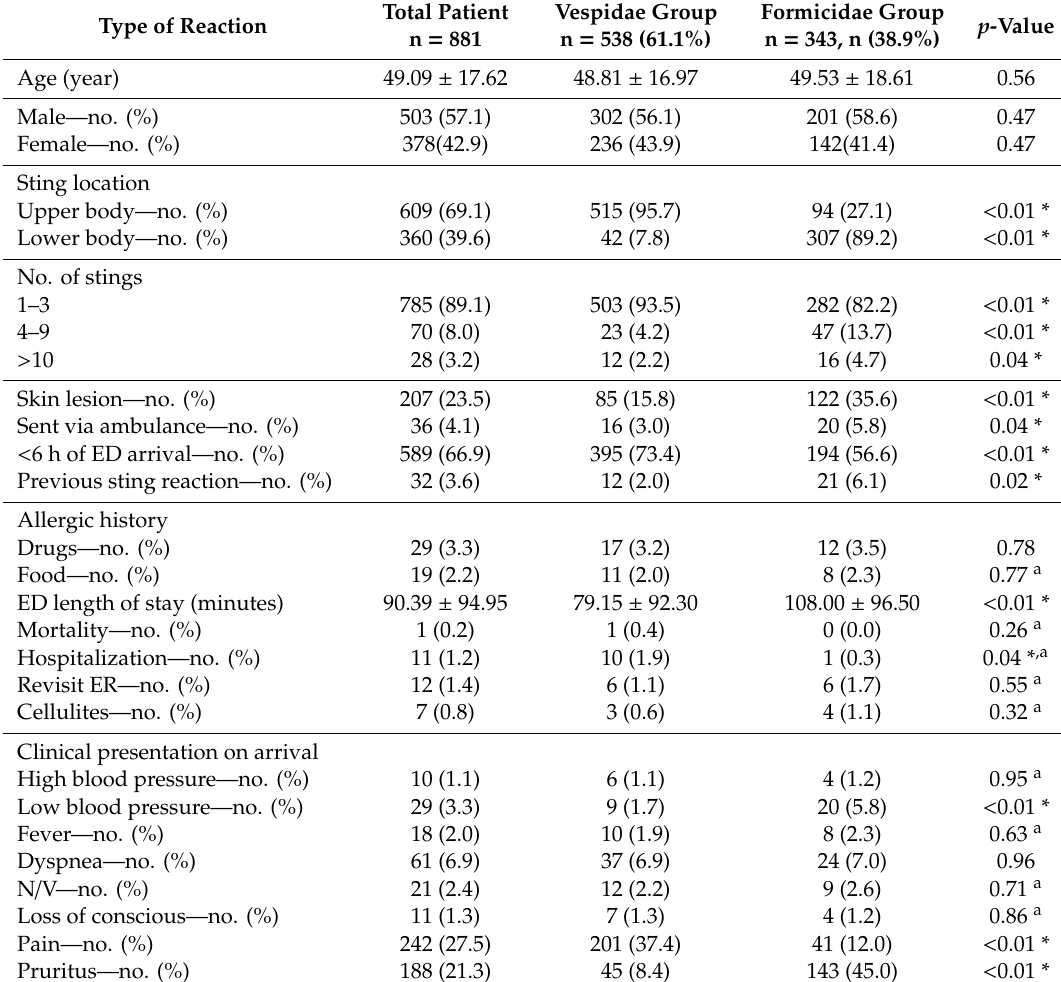
Table 1. Demographic data of the study